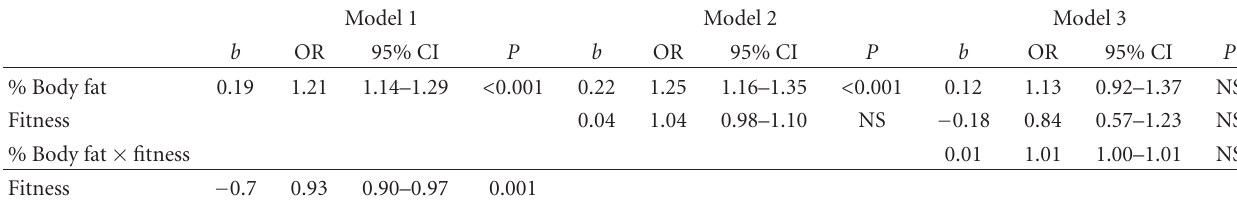
Table 2: Logistic regressions predicting the metabolic syndrome from percent body fat and estimated cardiorespiratory